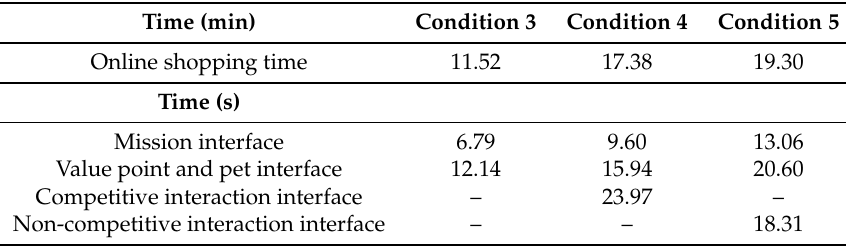
Table 1. Average time per person per session under each condition.